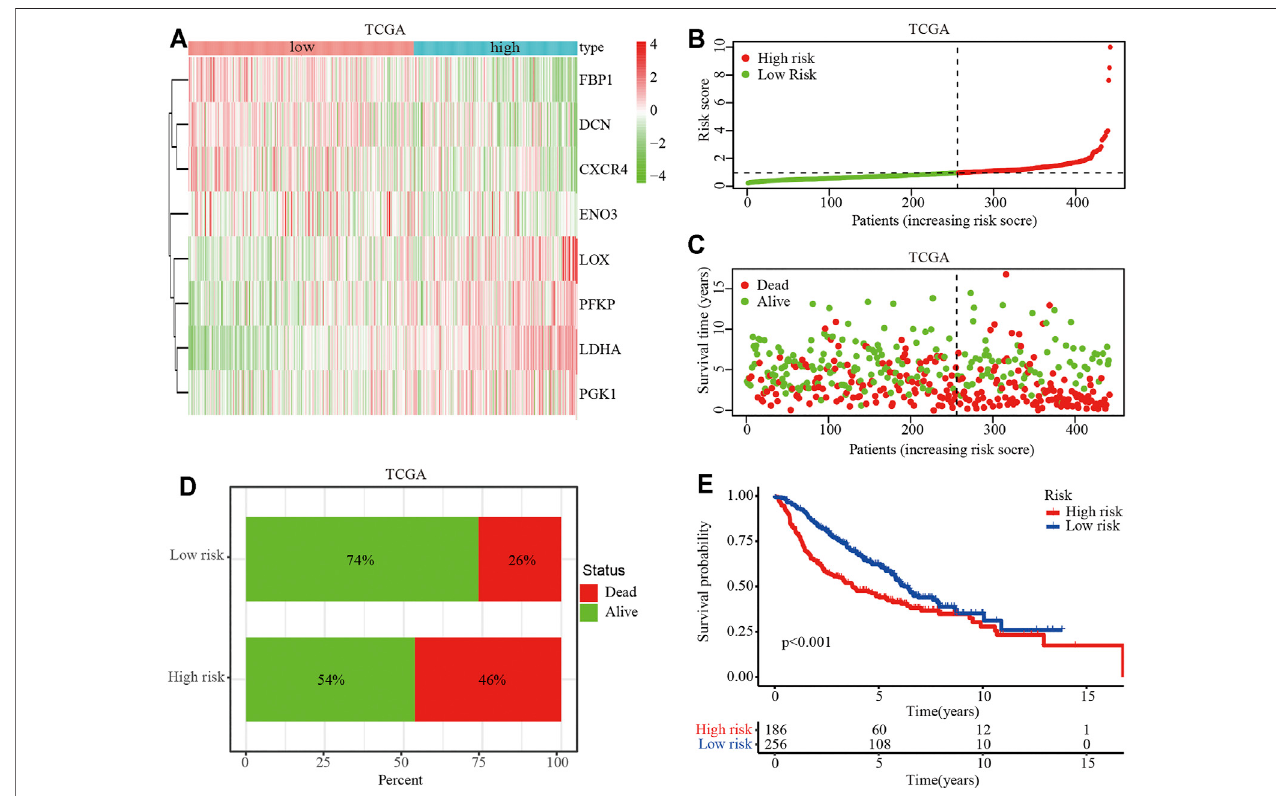
FIGURE 3 | Prognostic value of the hypoxia-related risk signature in the TCGA database. (A) Heatmap of high- and low-risk LUAD patients strati fi ed by eight key hypoxia-related genes in the TCGA cohort. (B) Distribution and median survival time of the high- and low-risk LUAD patients in the TCGA cohort. (C) Distribution of the survival status of high- and low-risk LUAD patients. The X -axis represents the number of patients, and the Y -axis represents the survival time. (D) Survival and mortality rates in the high- and low-risk LUAD patients. (E) OS analysis of high- or low-risk LUAD